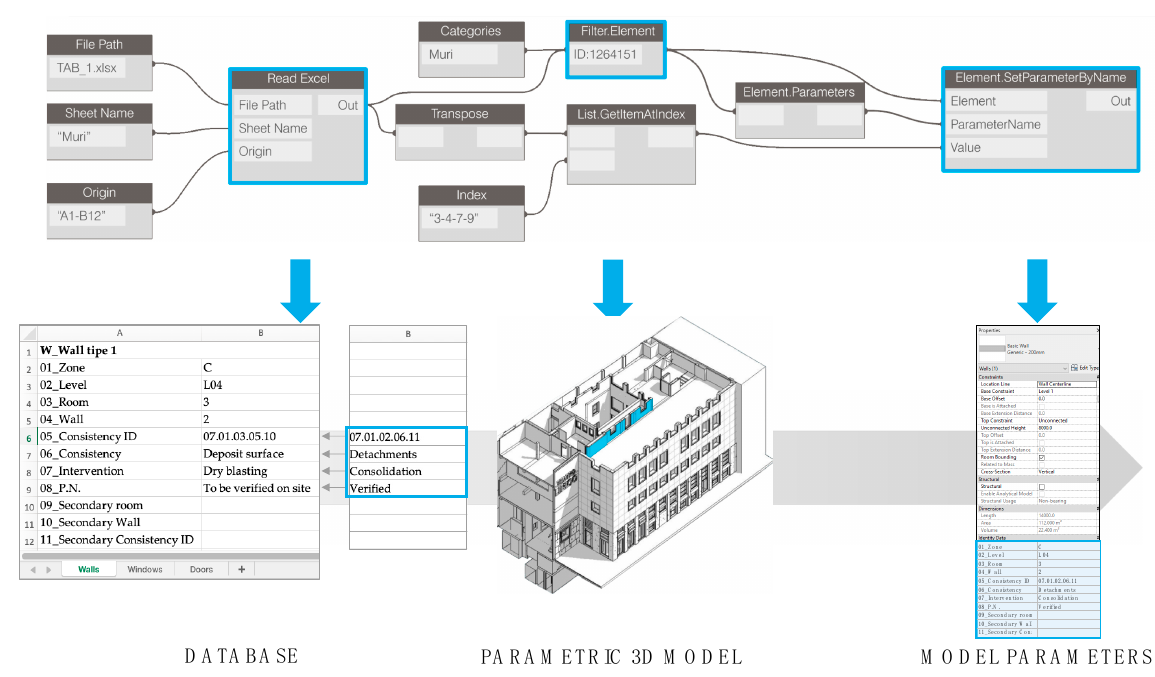
Figure 9. Process of updating the attributes.